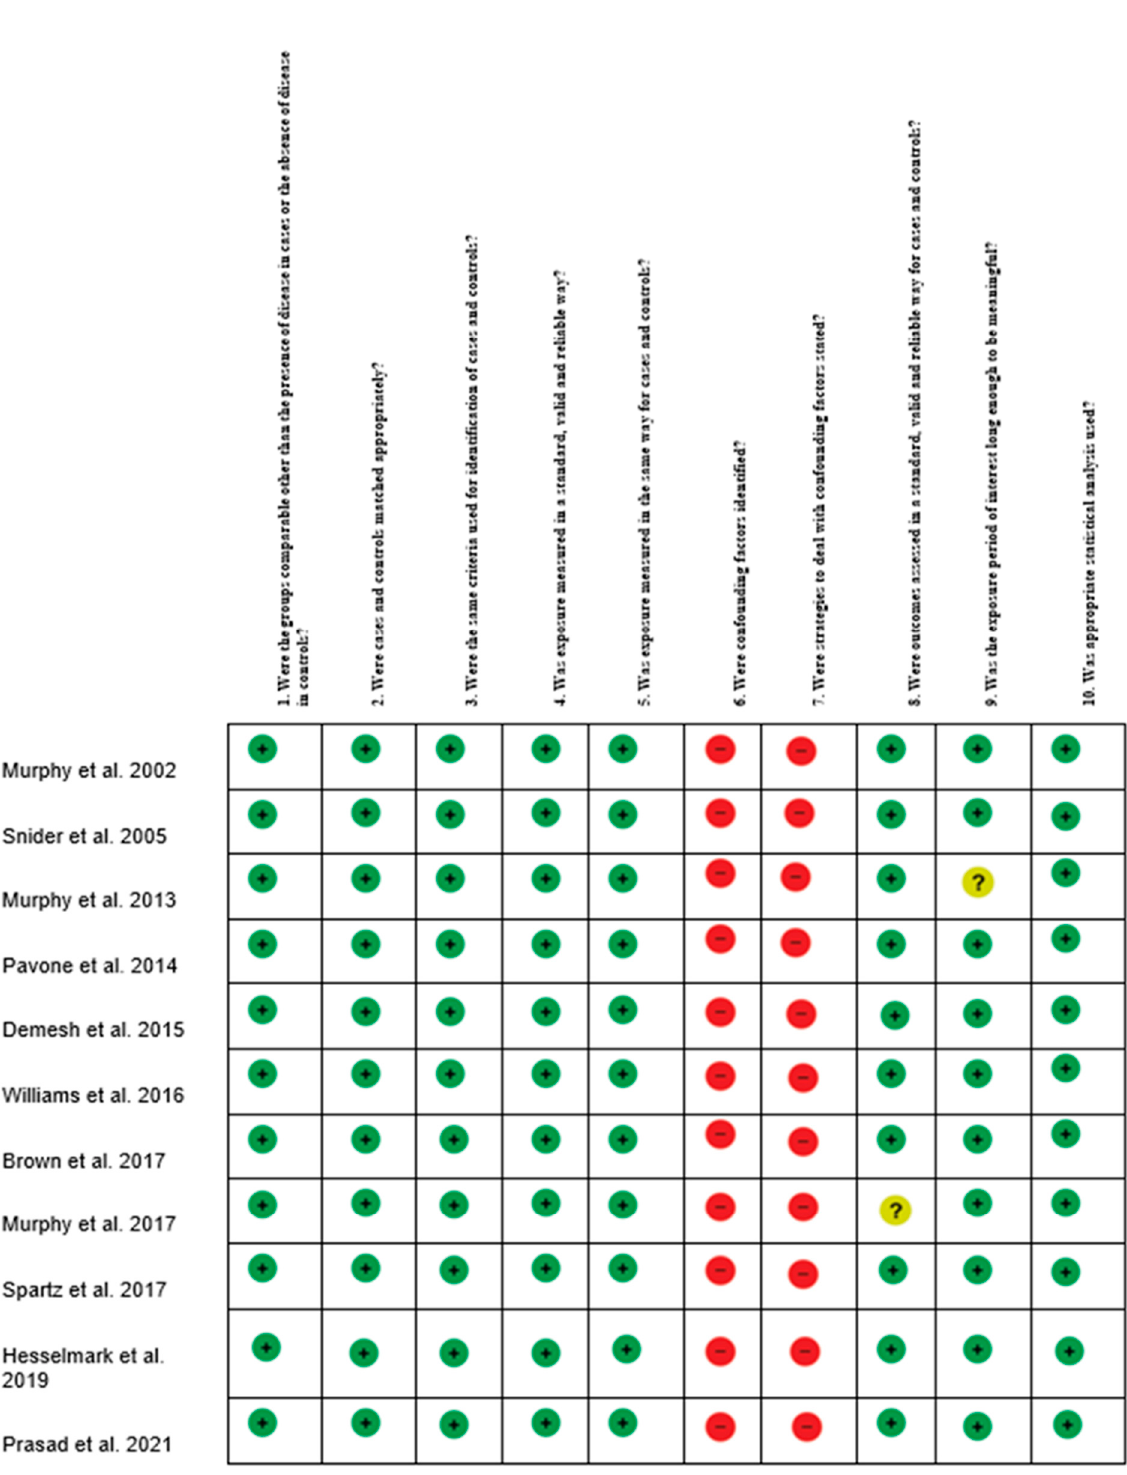
Figure 3. Risk of Bias summary author’s judgments for each included study, assessed by the Joanna Briggs Institute (JBI). Critical Appraisal Checklist for Case-Control studies.